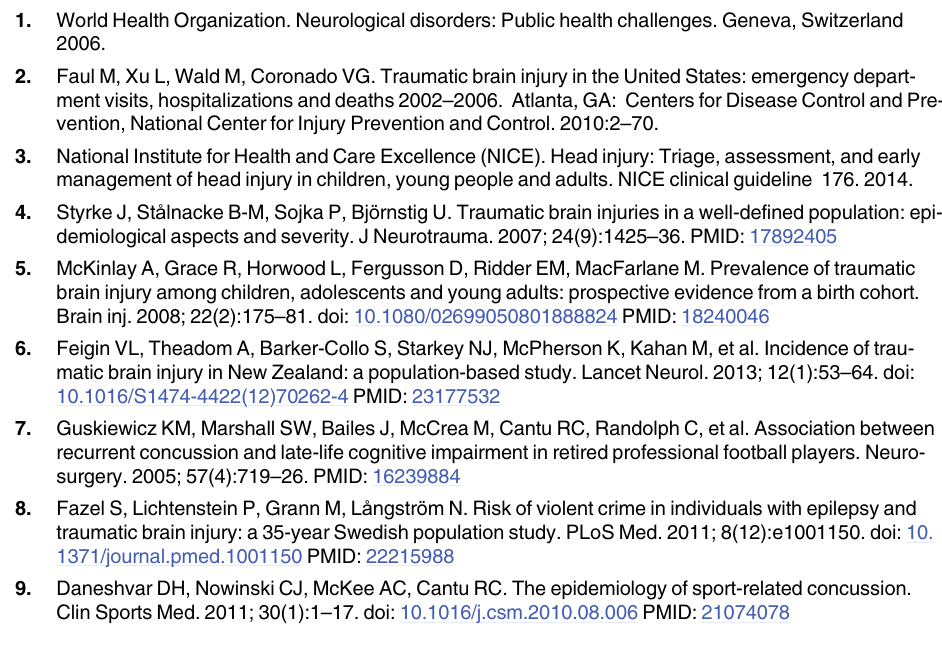
S3 Table. Number of events, time at risk, and Kaplan-Meier estimate (KME) or prevalence rate of adulthood functioning outcomes across TBI exposure up to age 25 y in the full sam- ple as well as the subsample of TBI-discordant siblings. S4 Table. Relative risks (RRs) and corresponding 95% confidence intervals (CIs) for the associations between TBI up to age 25 y and adulthood poor functioning in a subsample excluding any psychiatric or neurological conditions during the exposure period. S5 Table. Relative risks (RRs) and corresponding 95% confidence intervals (CIs) for the associations between TBI and adulthood poor functioning across age-band at first injury categories. S6 Table. Relative risks (RRs) and corresponding 95% confidence intervals (CIs) for the associations between mild TBI and adulthood poor functioning across age-band at first injury categories. S1 Text. Missing data